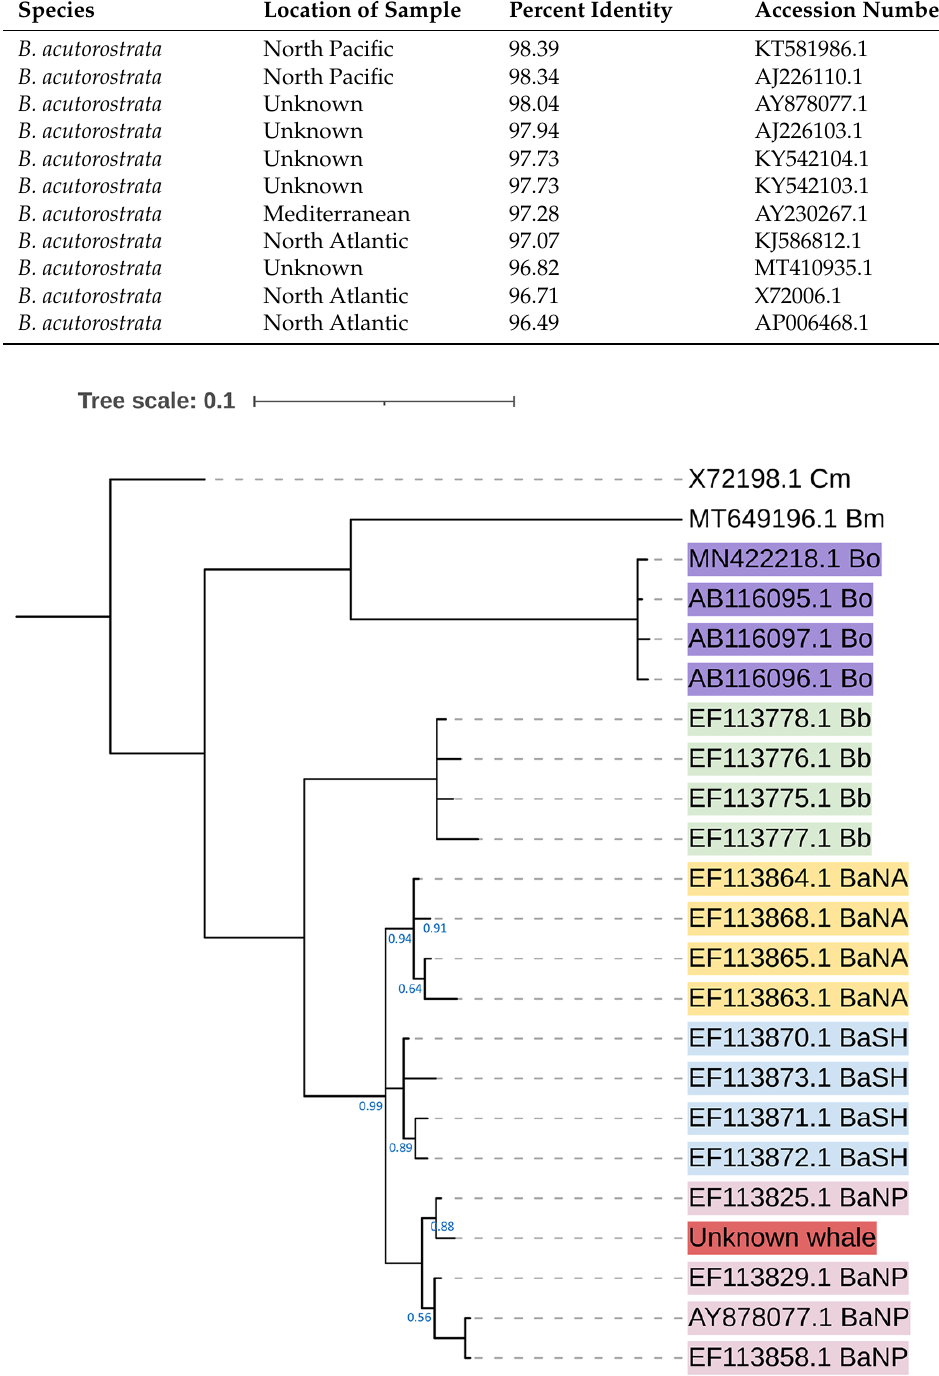
Figure 4. Bayesian phylogenetic tree of the unknown whale (accession number OQ446815), based on the HKY + G evolutionary model. Posterior probability (PP) value is shown below each branch. All branches had a PP value greater than 0.5. The branch without numbering indicates a PP value greater than 0.99. The accession number of each sequence is labeled at the tips. Cm = Caperea marginata , Bo = Balaenoptera omurai, Bb = Balaenoptera bonaerensis , BaNA = Balaenoptera acutorostrata from North Atlantic Ocean, BaSH = Balaenoptera acutorostrata from the southern hemisphere, BaNP = Balaenoptera acutorostrata from North Paci fi c Ocean, unknown whale = sample from this study.